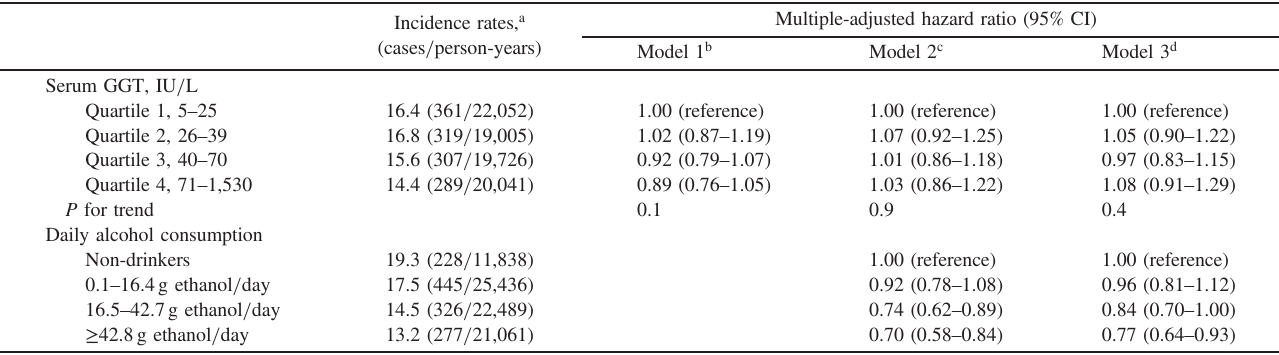
Table 3. Multivariate model of the incidence of low eGFR according to baseline serum GGT and alcohol consumption ( n = 9,299) Incidence rates,